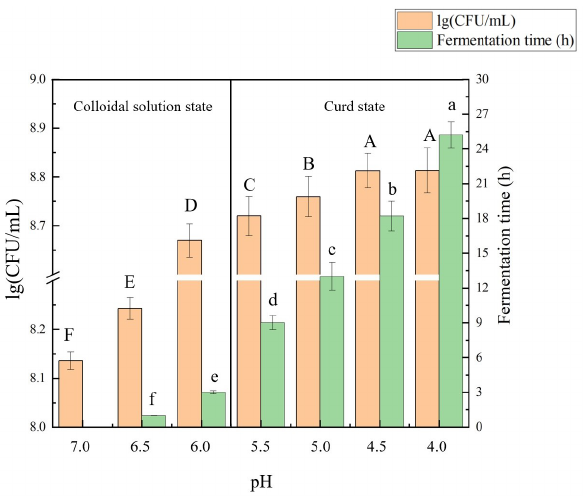
Figure 1. Fermentation time, viable cell counts, and interaction between proteins of FSPI at varied levels of terminal pH. Different letters indicated significant difference ( p < 0.05) between the FSPIs at different levels of terminal pH.